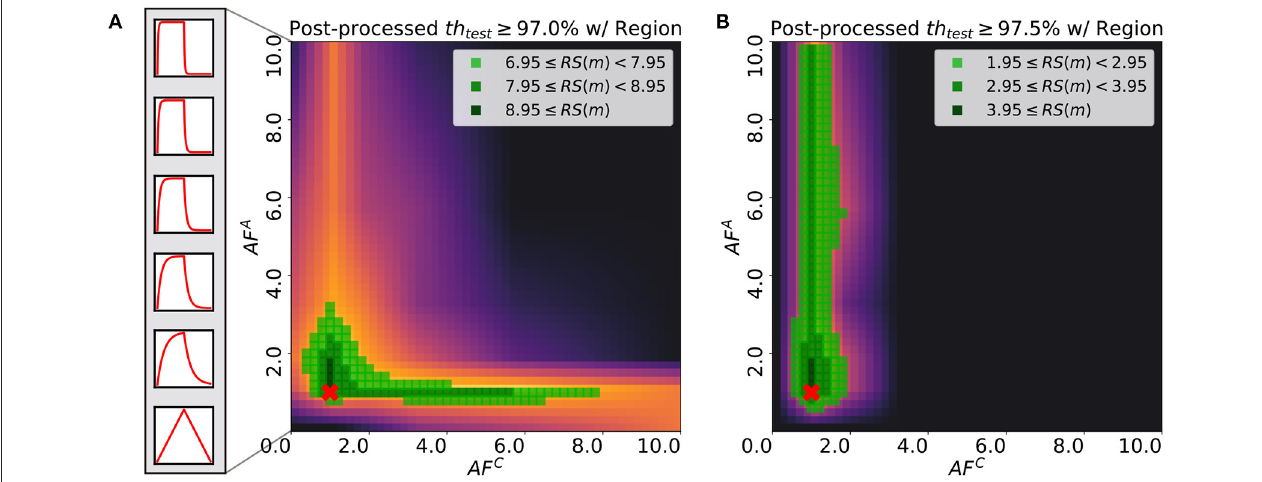
FIGURE 9 | Post-processed test robustness score on various thresholds: (A) 97.0 % and (B) 97.5 % . The green-colored regions are highlighted with different light and shade. Red cross point indicates the pair of asymmetric factors for baseline model used in original Tiki-Taka algorithm (Gokmen and Haensch,2020). Boxes on the left side of (A) show the asymmetry of device response in accordance with each asymmetric